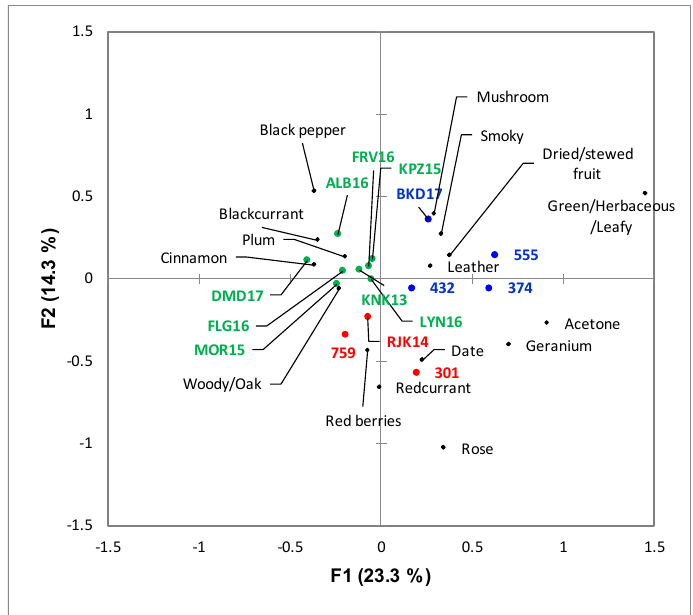
Figure 4. HCA cluster profile plot for Pinotage. The blue and red arrows indicate negative and positive drivers of quality, respectively. The color of the graph lines corresponds to the clusters indicated in Figure 3.